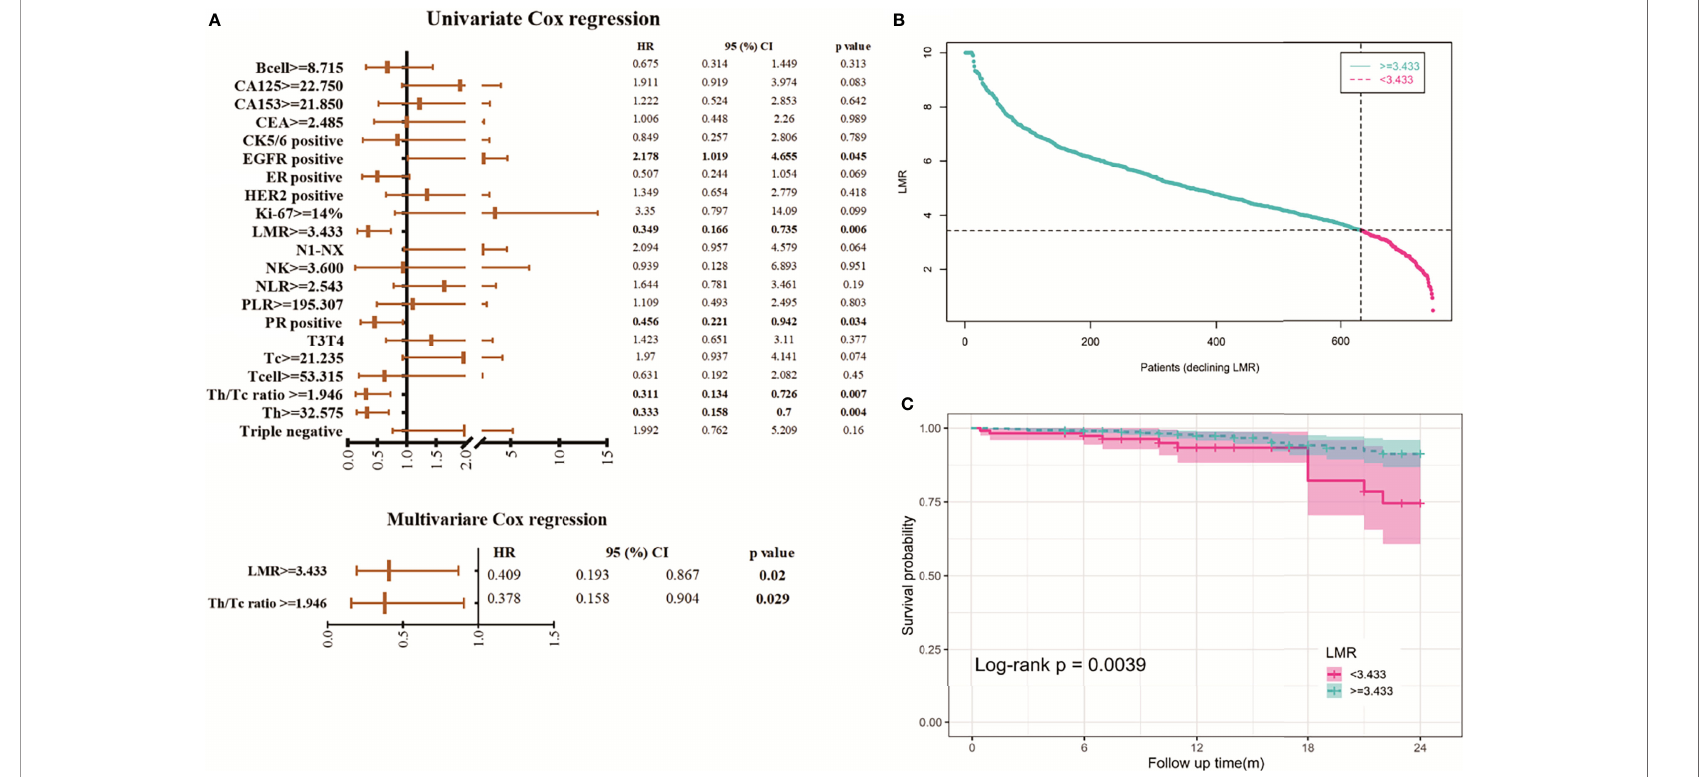
FIGURE 5 | Assessment of the prognostic risk model of LMR and clinical features in stage I-III BC. (A) Univariate and multivariate analyses of the clinical characteristics and LMR with the DFS. (B) Distribution of LMR risk score for the stage I-III BC. (C) Kaplan-Meier survival curves of the DFS of patients in the different LMR groups for stage I-III